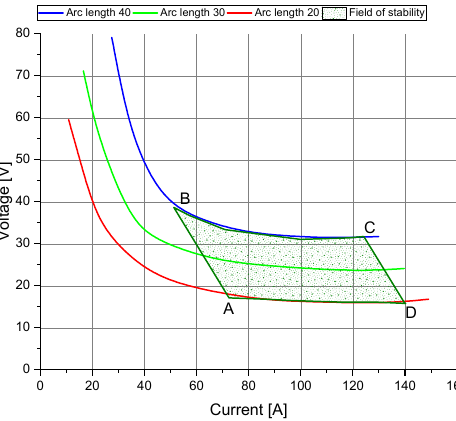
Figure 1. Example of a field of stability for the DC transferred arc.